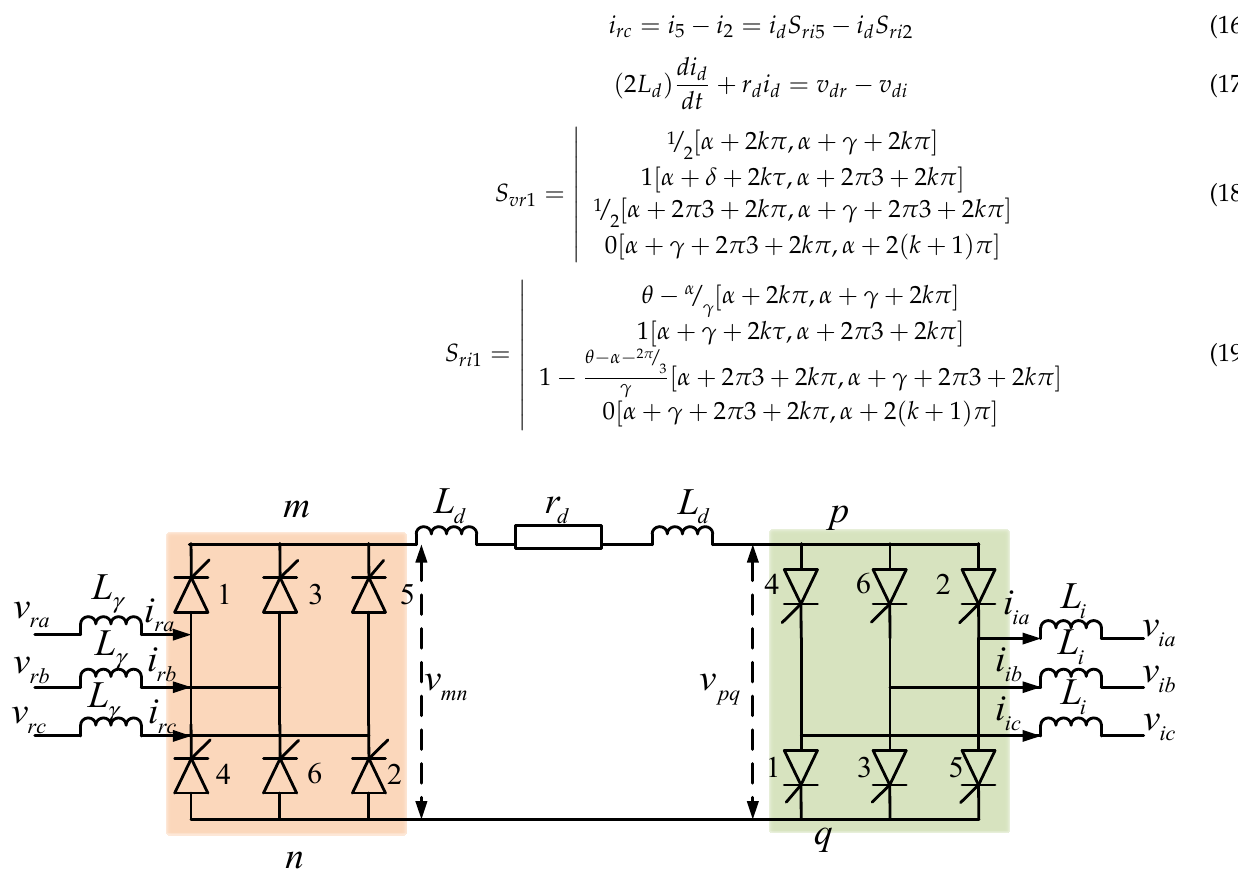
Figure 10. Dynamic phasor diagram of the HVDC system.